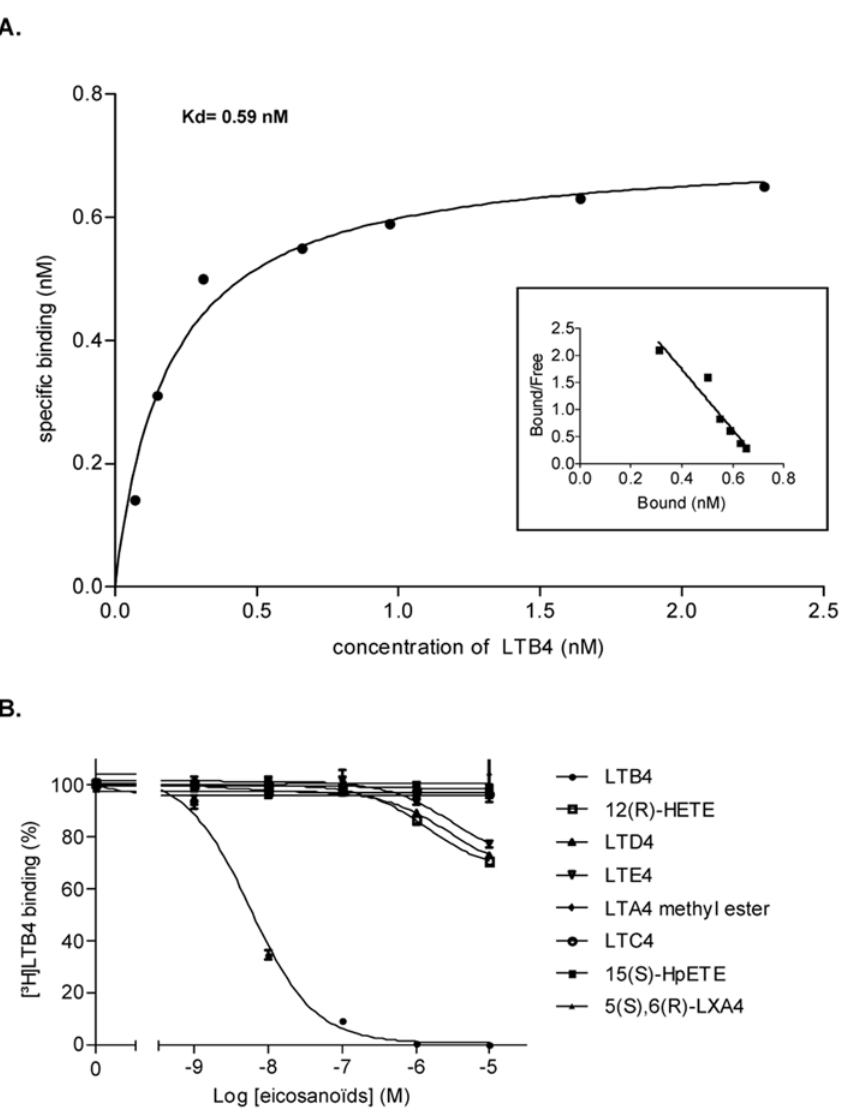
Figure 1. Binding of 3 H-LTB4 to Ir-LBP. a) Saturation curve and scatchard analysis for LTB4 binding to Ir-LBP. b) Inhibition of 3 H-LTB4 binding to Ir-LBP by eicosanoı¨ds. The binding of 1 nM 3 H-LTB4 was subjected to competition with the indicated concentrations of the indicated